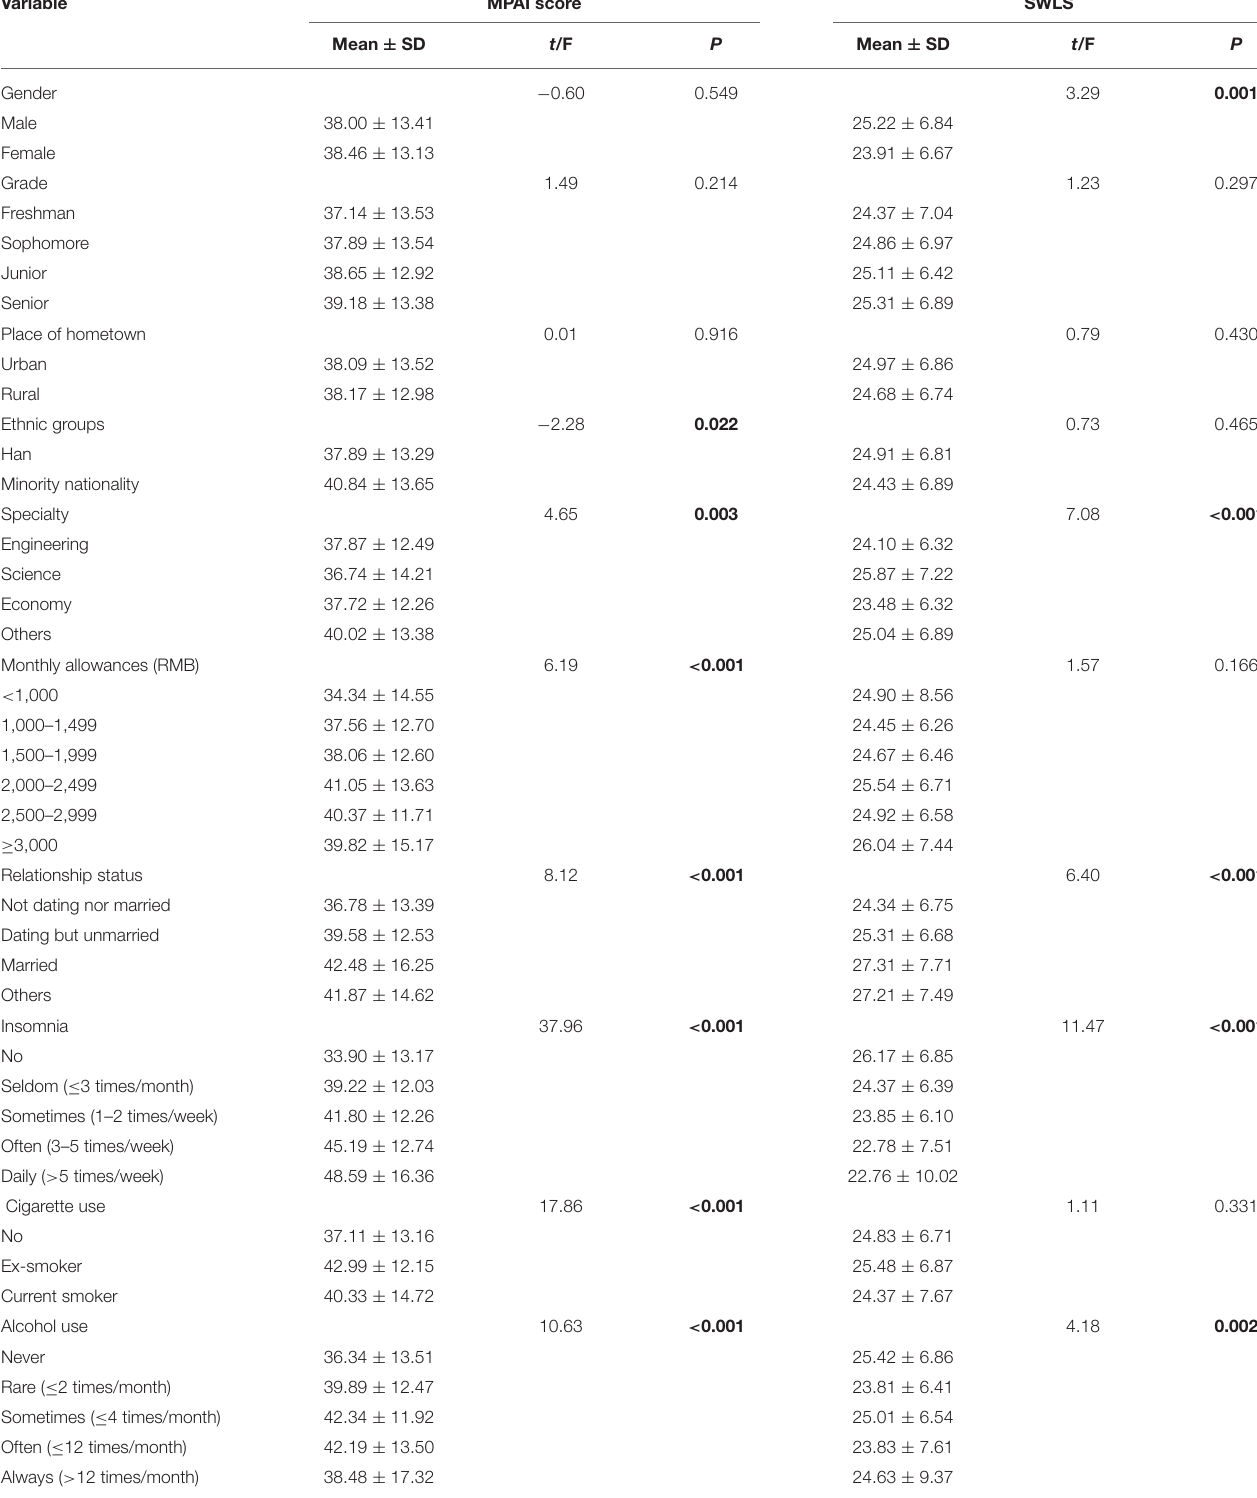
TABLE 2 | Univariate analyses of factors associated with PMPU and SWLS.